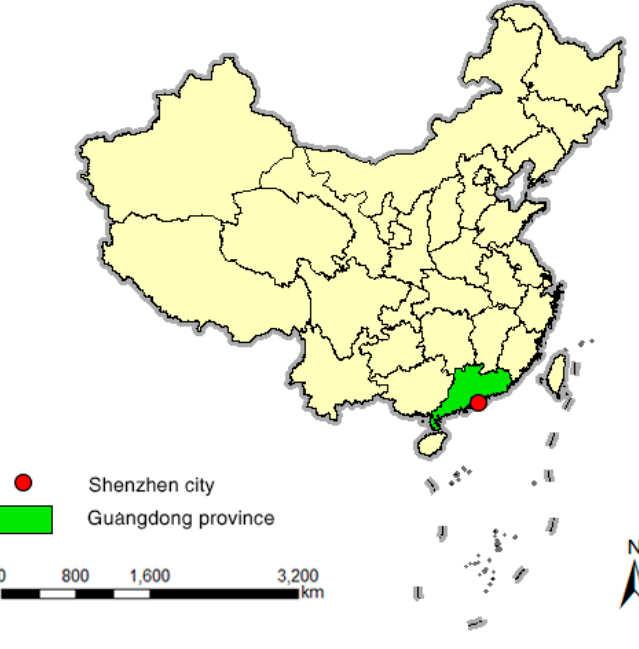
Figure 1. The city of Shenzhen, Guangdong, China.